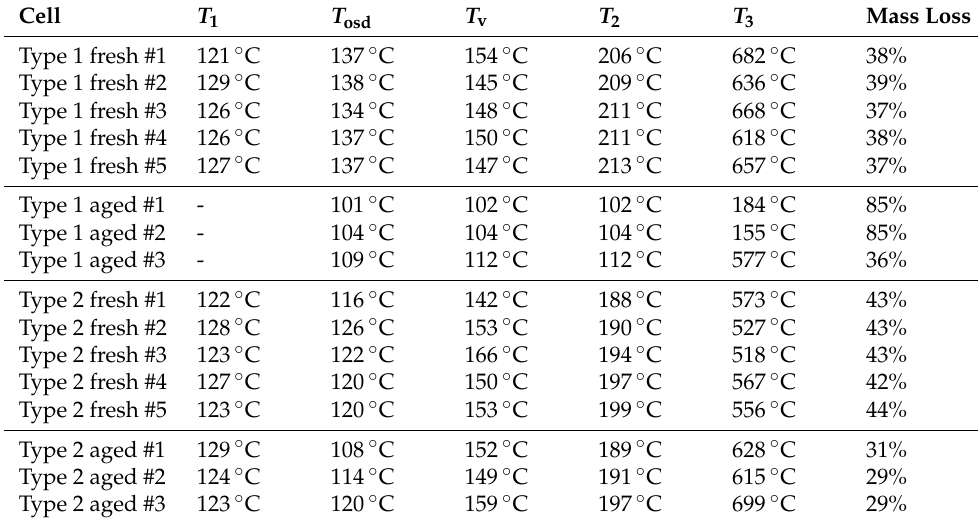
Table 2. TR behaviour and mass loss of all tested